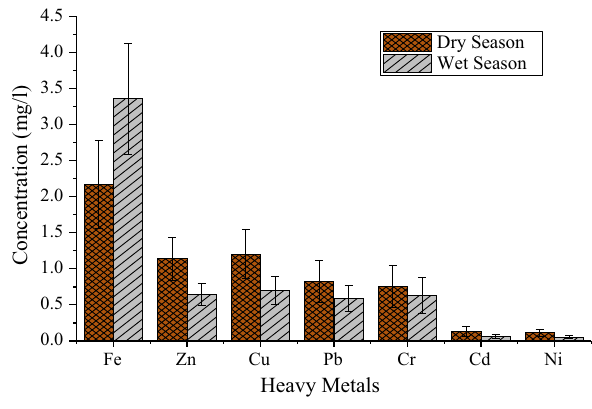
Fig. 2 Heavy metal concentration during dry and wet